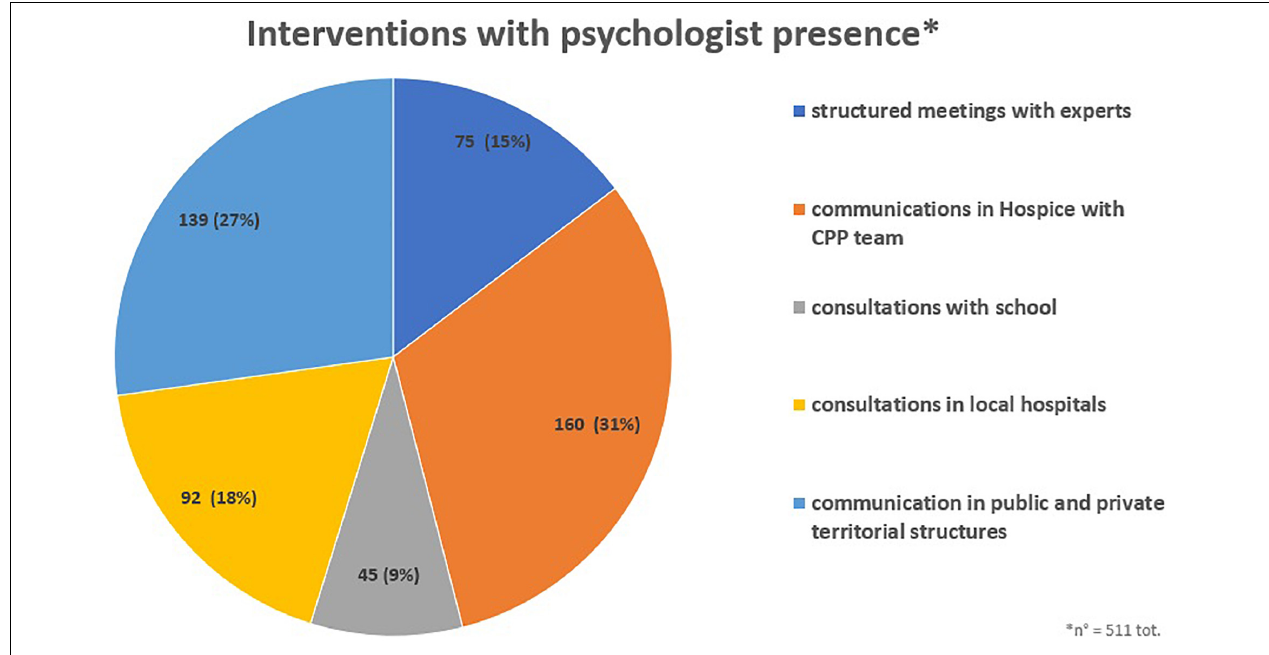
FIGURE 1 | Interventions with psychologist.